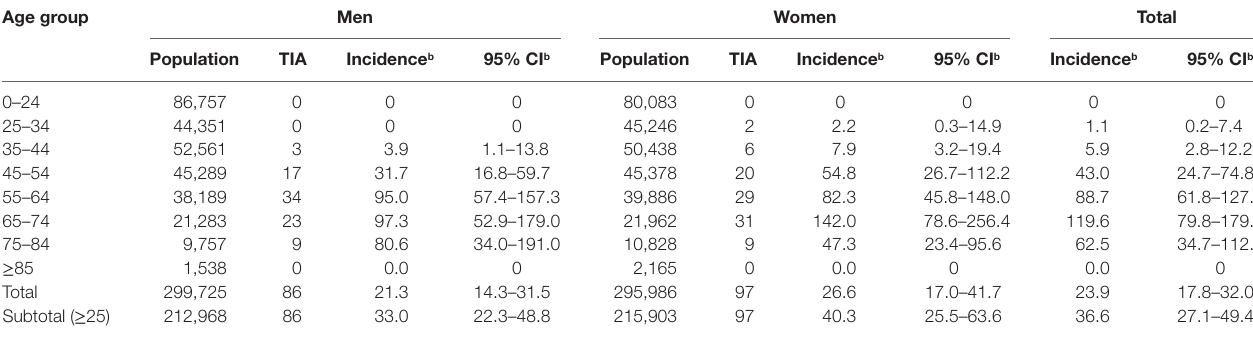
Table 3 | Incidence a of transient ischemic attack (TIA) in China, 2013 (1/100,000 person*years). age group Men Women